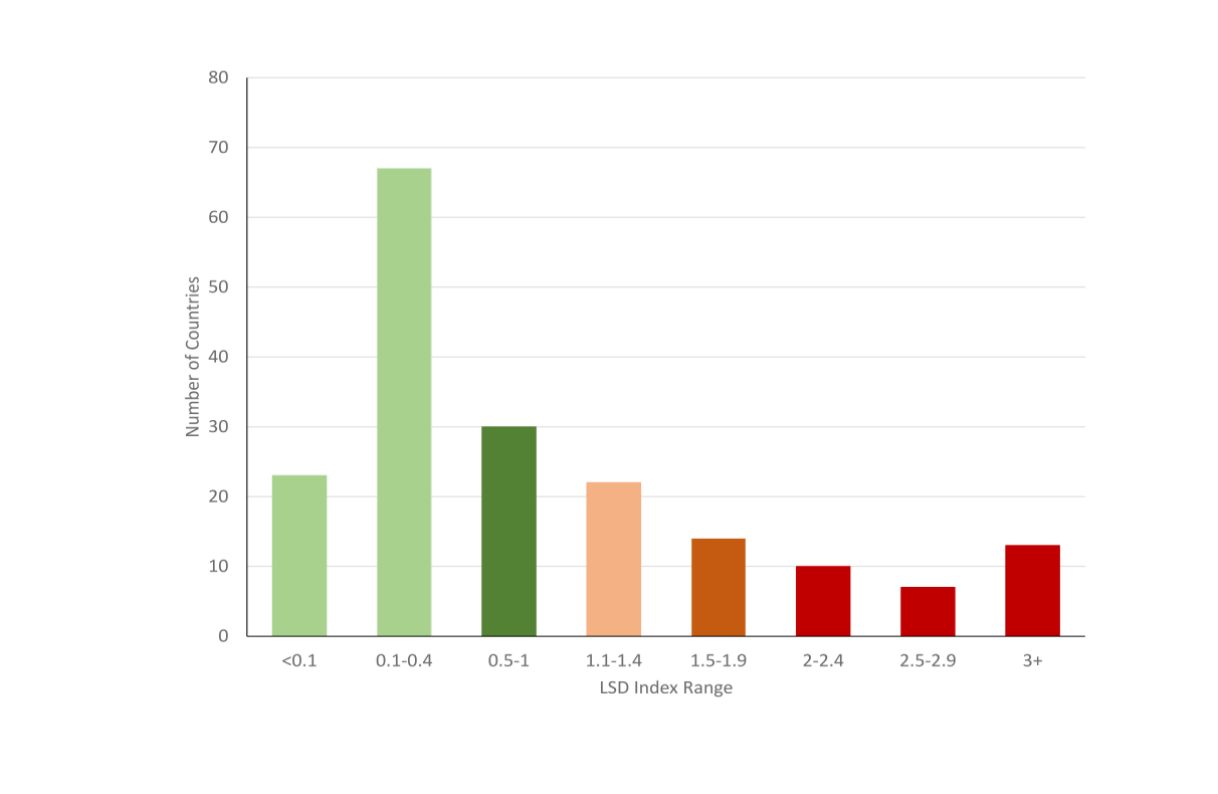
Figure 4. The number of countries and regions by ranges of the LSD index. As of July 5, 2020, the LSD index in 120 countries and regions was less than 1. The LSD index was greater than 1 in 66 countries and regions. LSD: lifting social